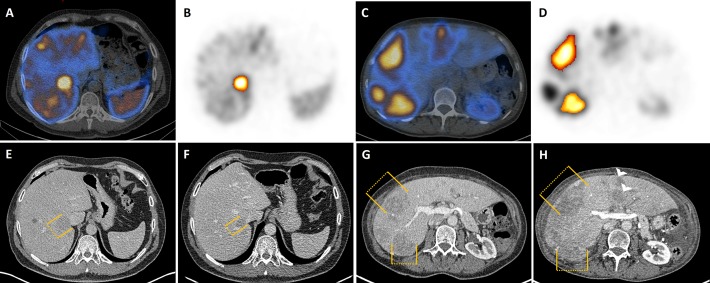
Representative responding lesion (RL) and non-responding lesion (NRL).Baseline SPECT/CT during dosimetry (24h p.i.). Representative example of one responding lesion in liver segment VI (A) of a 48-year-old man suffering from metastatic duodenal NEN. The lesion can be detected on SPECT (B) and is illustrated by orange bars on CT at baseline (E) and after 12 months follow-up (F). The lesion decreased from 3.9 cm with a functional SPECT-volume of 19.7 ml to 2.3 cm after 4 cycles’ [177Lu]DOTATATE-PRRT and 12 months follow-up, respectively. Images (C,D,G,H) showing a typical example of non-responding lesions. A 59-year-old woman suffering from pancreatic (P)-NEN with predominant liver metastases. Hepatic metastases can be detected on CT (G) as well as on SPECT (D) and image fusion, SPECT/CT (C). The lesions’ measurements are displayed by orange bars. Two exemplary lesions in liver segment VII and VIII (G) are shown with a maximum diameter of 3.5 cm (functional tumor volume [FTV] 26.4 ml) and 4.6 cm (FTV 34.0 ml) prior to treatment. After two cycles of [177Lu]DOTATATE-PRRT, tumor diameters increased to 4.2 cm (segment VII) and 7.0 cm (segment VIII). As an additional finding, new metastases are highlighted with white arrow heads (H).